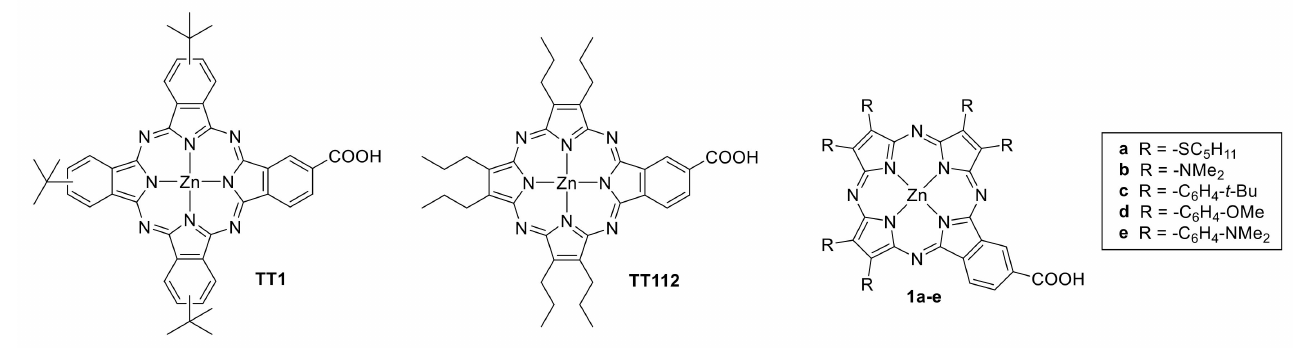
Figure 1. Chemical structures of Pc TT1 , TT112 , and Pzs 1a-e